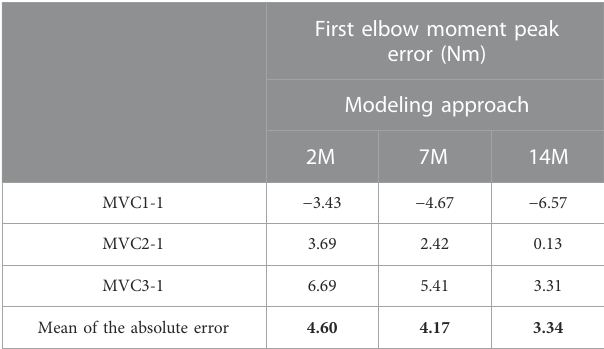
TABLE 2 RMSE during each MVC using physiological optimization.